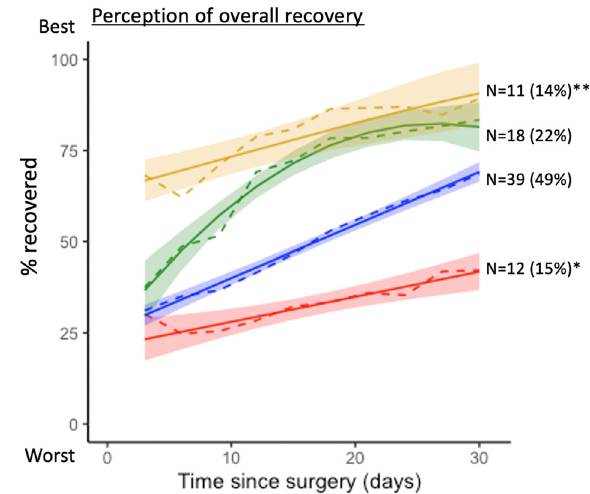
Fig. 1 Trajectories of patient perception of overall recovery. The fi gure shows four trajectories of overall recovery on the patient- reported scale of 0 to 100%. The trajectory groups were identi fi ed by fi tting the group-based trajectory model. The yellow curve depicts the best recovery trajectory, including 11 patients, and the red curve depicts the worst recovery trajectory, including 12 patients. Trajectory with a single asterisk (*) denotes the worst recovery trajectory and the trajectory with double asterisks (**) denotes the best